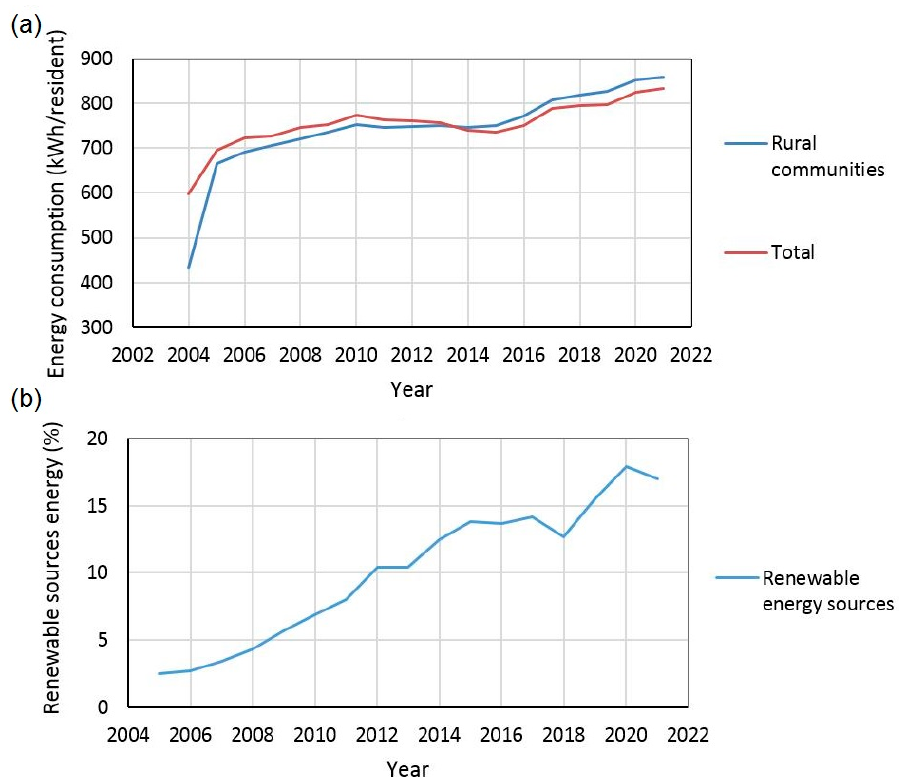
Figure 9. Electric energy in rural areas of Poland, data obtained from [66]: ( a ) annual domestic electric energy consumption per one resident, ( b ) share of the renewable energy sources in the total production of energy in Poland.